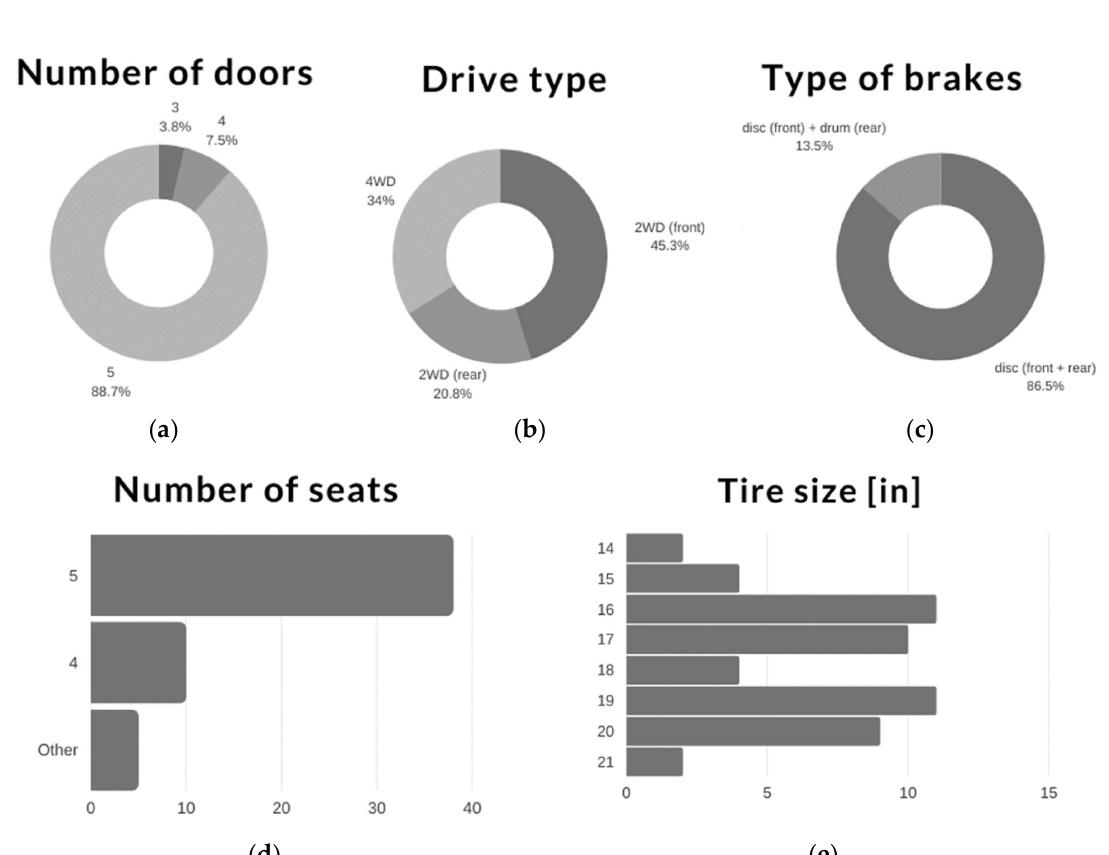
Figure 1. The structure of the dataset: ( a ) number of doors; ( b ) drive type; ( c ) type of brakes; ( d ) number of seats; ( e ) tire size. Table 2. Descriptive statistics for extracted groups— battery and others .